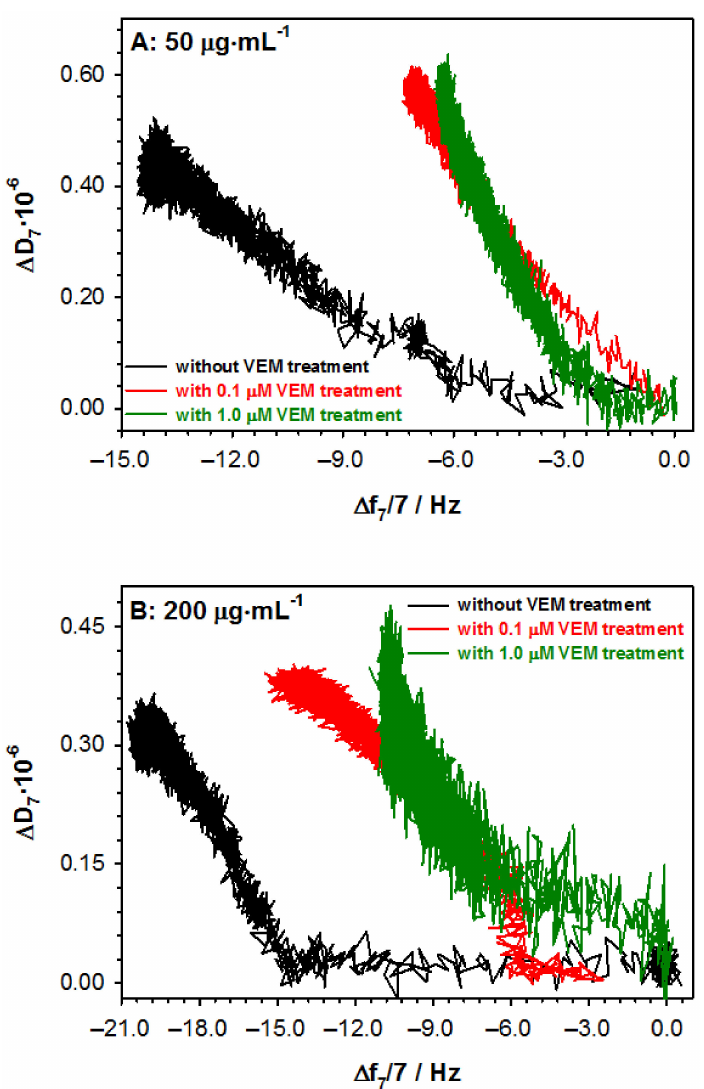
Figure 3. ∆ D versus ∆ f plots of Con A binding to AGP layer (Au/4MBA/AGP) untreated and treated with VEM for 50 ( A ) and 200 µ g · mL − 1 . ( B ) Con A concentration. Experimental conditions: PBST buffer with the addition of 1%